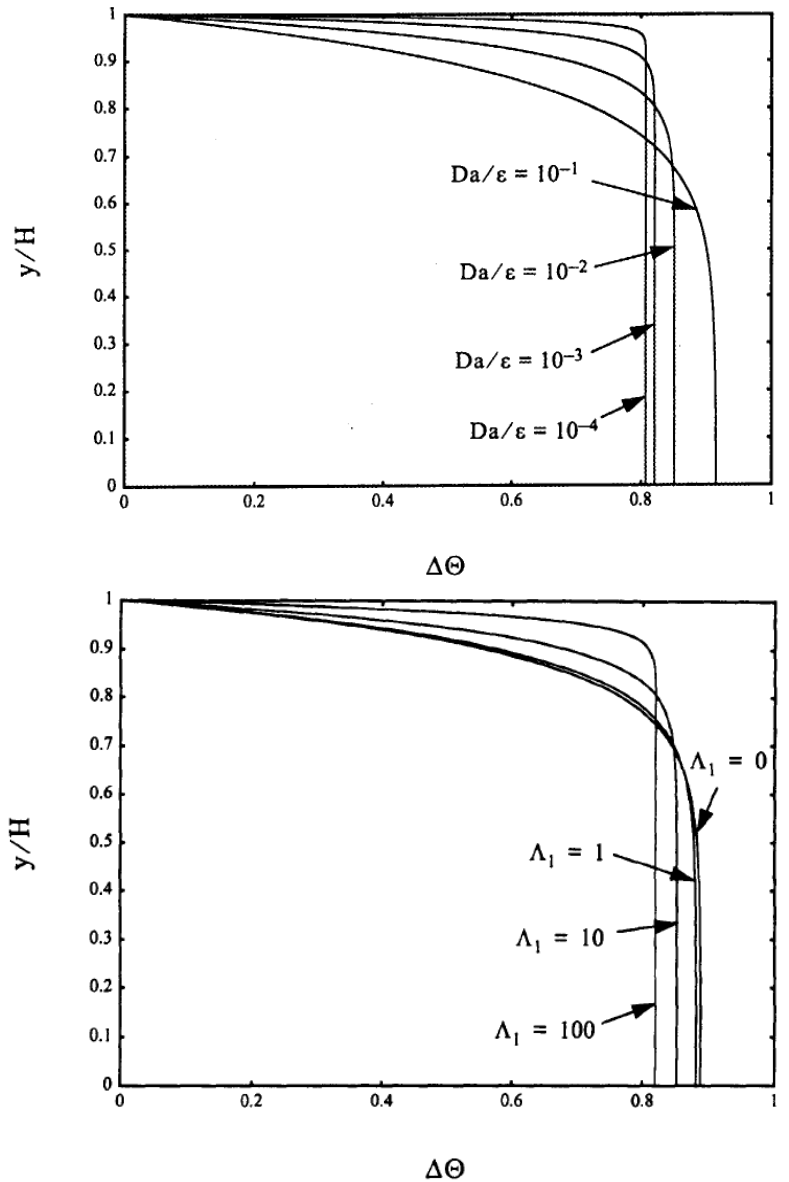
Figure 5. Profiles of local temperature difference ( ∆Θ ) between solid and fluid phases inside a porous channel, for ( Top ) various Darcy numbers at ( Λ = 10), and ( Bottom ) various inertial parameters at (Da/ ε = 10 − 2 ), reported by Kuznetsov